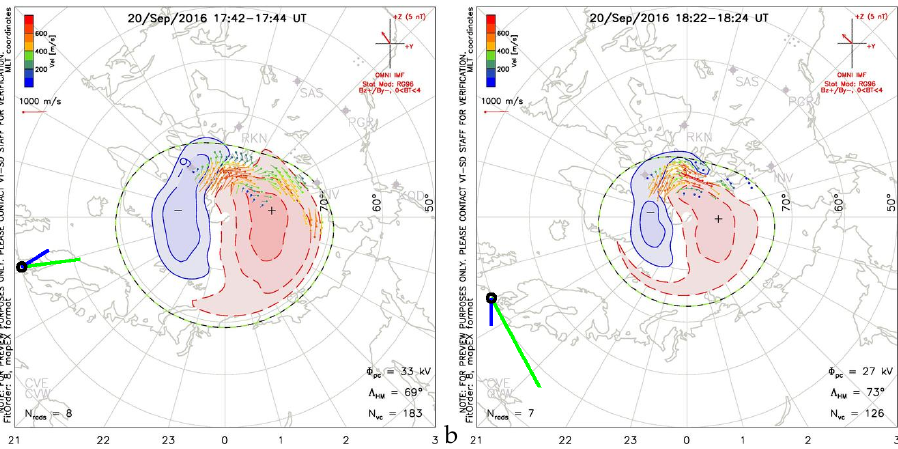
Figure 14. Qualitative caption. comparison of drift estimation by two methods, according to for- mula (12)—green—and formula (20)—blue—with ionospheric convection obtained by the Super- DARN system for moments: marked in Figure 10a,b with green vertical lines, for the quiet time (set L547449); panel ( a ) for 17:42 UT, and panel ( b ) for 18:22 UT of 2016.09.20.